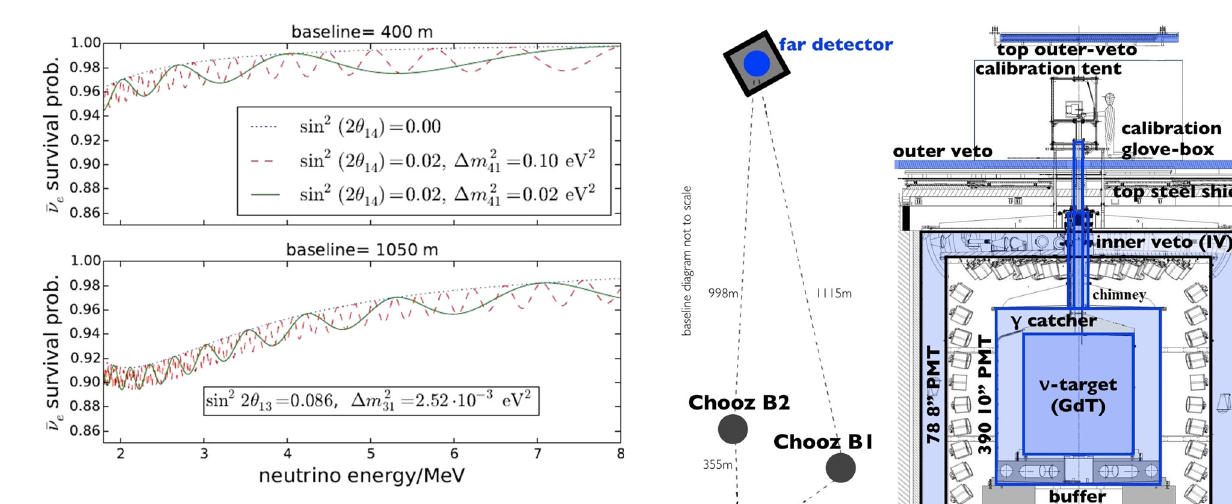
Fig. 1 Survival probability of reactor ν e as a function of the energy for the baselines of the ND (top) and FD (bottom) for different benchmark oscillation parameters θ 14 and Δ m 2 . The dotted line corresponds to the 41 no-sterile case, where the survival probability is governed by the con- Fig. 2 The Double Chooz experiment. Left: arrangement of the two ventional θ 13 oscillation. The dashed and solid lines show two different detectors far and near with respect to the nuclear reactors. Right: design examples of sterile mixing of a Double Chooz detector. Figure modified from